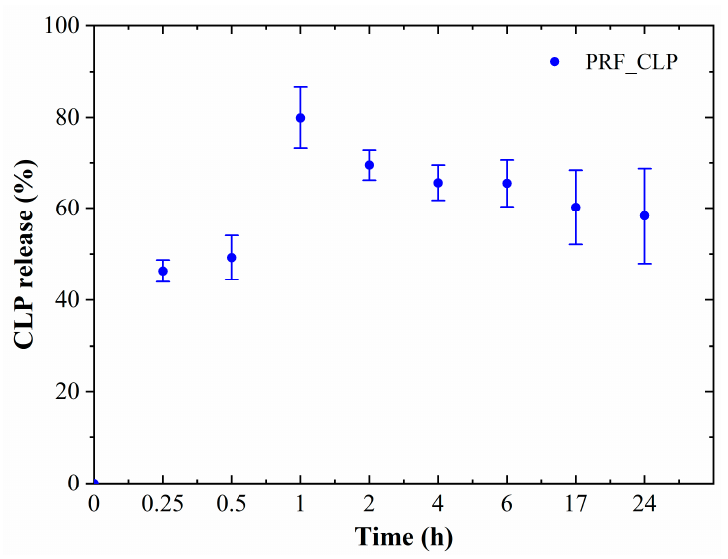
Figure 4. CLP release from PRF matrices in DMEM; average of 3 donor release data.